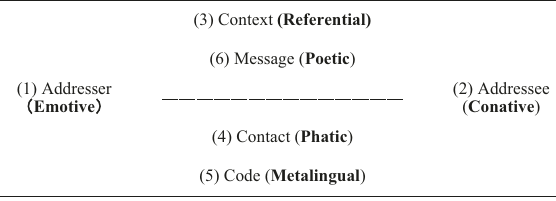
Fig. 1 Communication model in Jakobson (1960). Source: partially modi fi ed from Jakobson (1960, p. 3, 7).